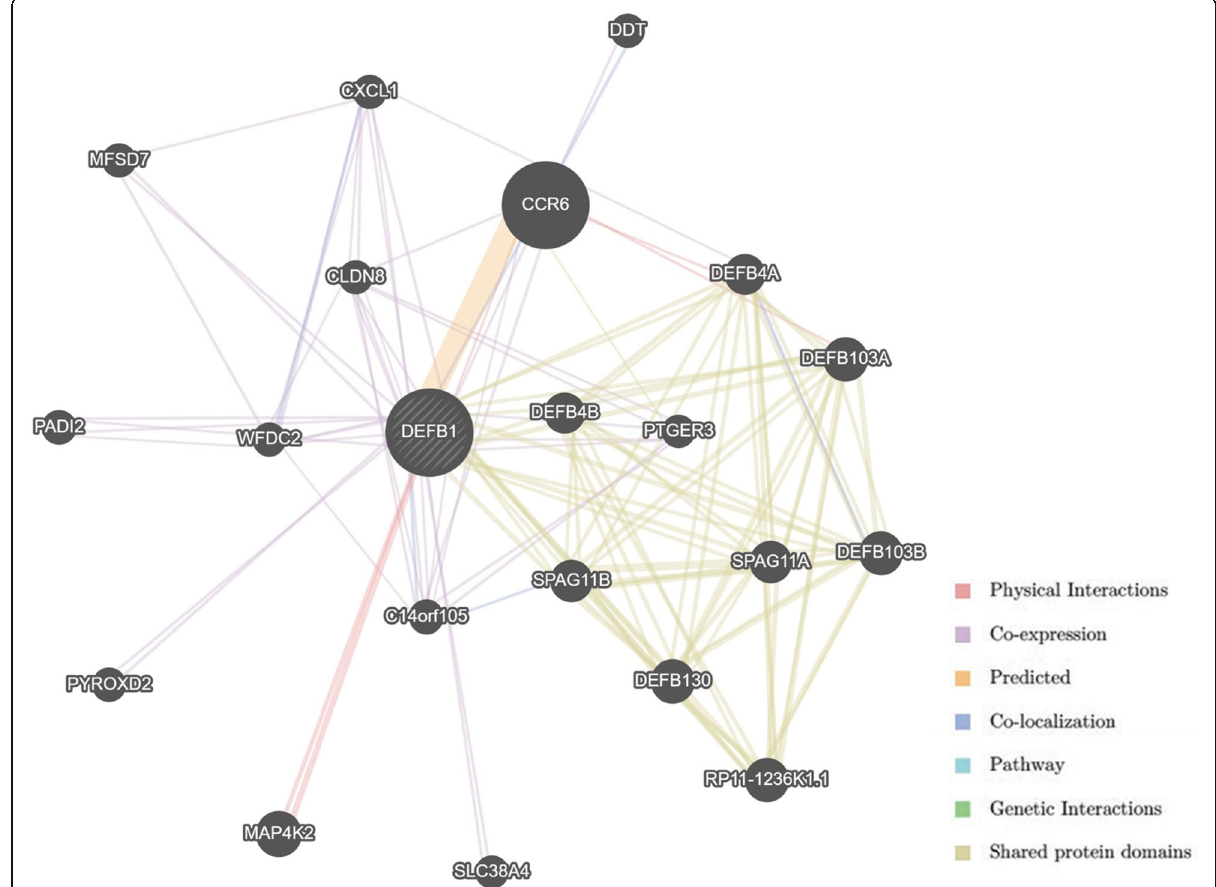
Fig. 1 Gene-gene interaction network of the DEFB1 gene predicted by